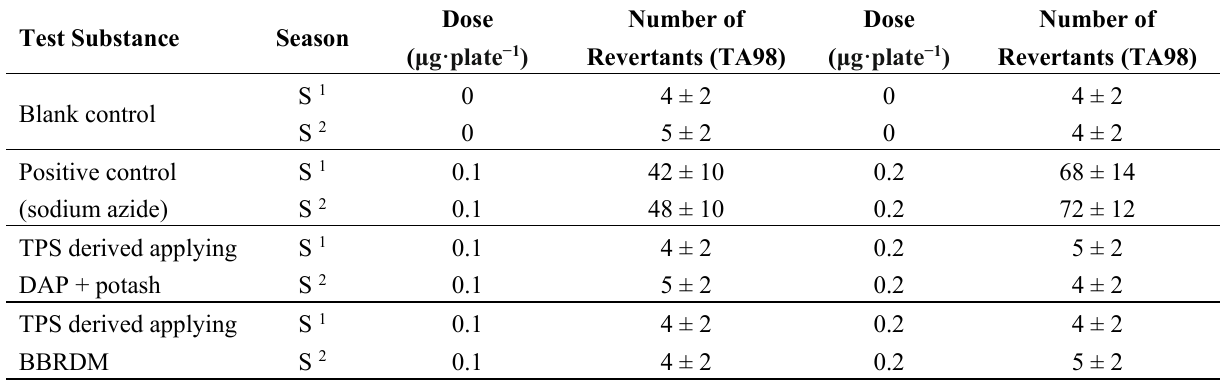
Table 3. Dose–response relationship between tomato powder suspension (TPS) and the number of revertants observed in the Ames (bacterial reverse mutation)